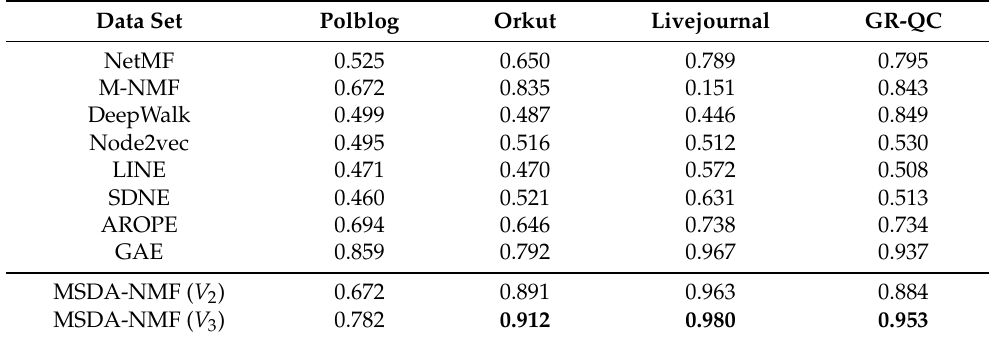
Table 4. Experimental results of link